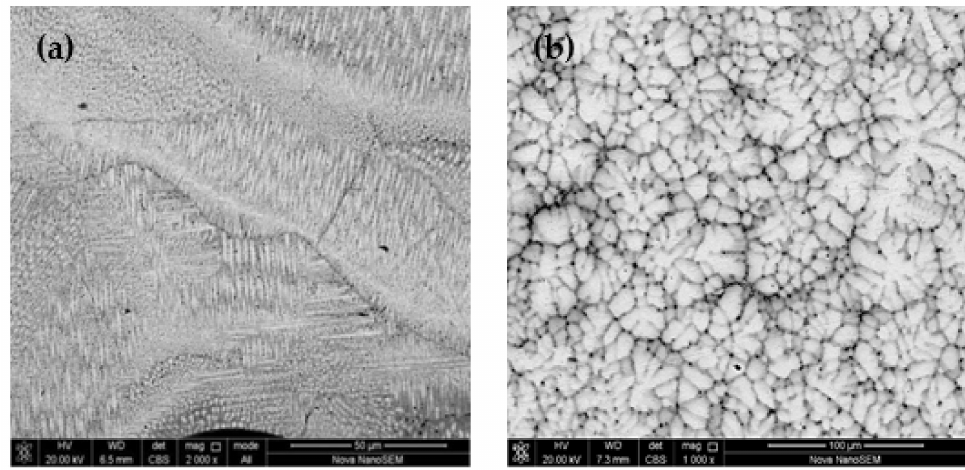
Figure 3. SEM image of MoNbTaWTi Arc surfacing layer: ( a ) bottom layer and ( b ) middle layer. The alloying elements of surfacing formed layers looked uniformly distributed with- out obvious component segregation. However, the micro-scaled area-scanning results of distributed elements displayed concentrated W and Ta elements in the dendrites (Figure 4). By comparison, the Ti element was mostly distributed at the intergranular, and both Nb and Mo were evenly distributed in both regions. Moreover, this means that certain dendrite segregation existed. Table 1 provides each element’s segregation rate (SR), defined as the ratio of elements in intragranular to intergranular phases. Note that more deviation between SR and 1 led to more serious dendrite